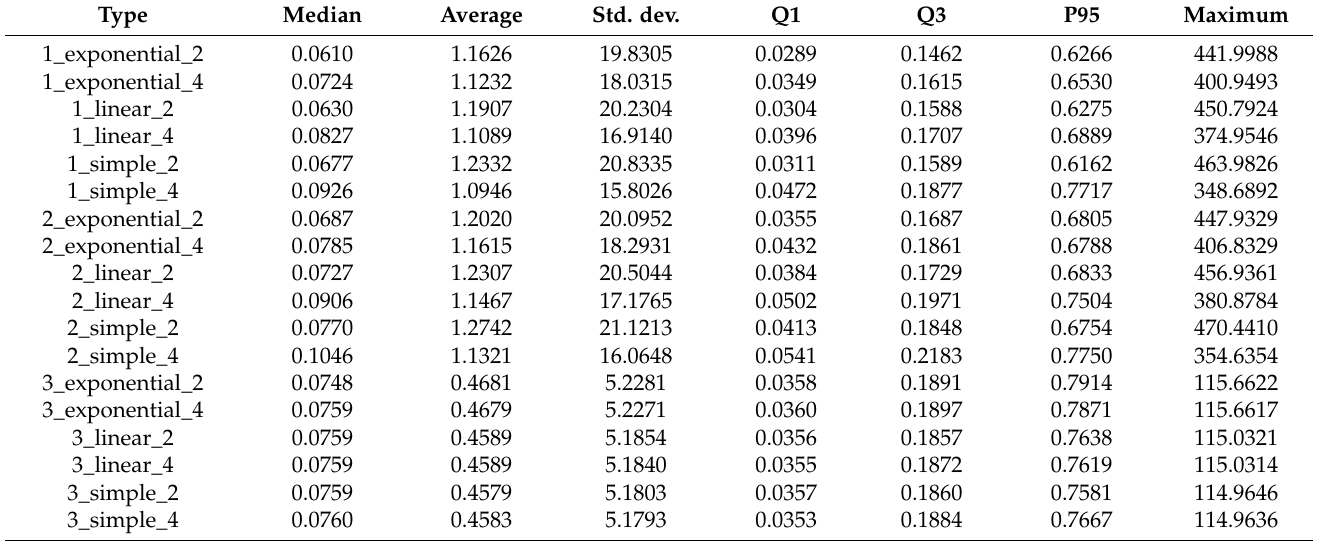
Table 3. MAPE statistics for the second set of missing data (2—continuous).